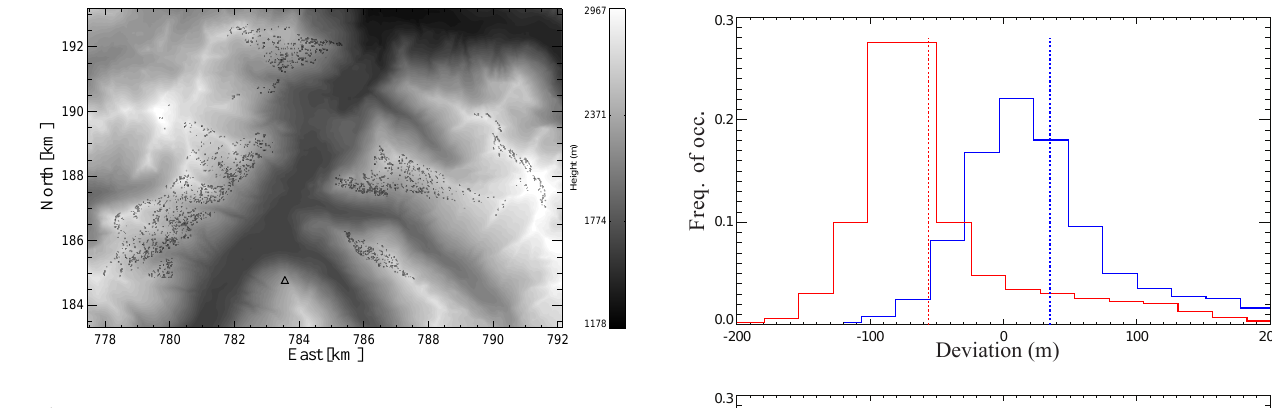
Fig. 8. Histogram of the altimetric deviations between the projected ground echoes and the reference DEM provided by Swisstopo: before pointing correction (top) and after (bottom). The red histogram corresponds to Position 1, the blue one to Position 2. The vertical dashed lines indicate the mean values.